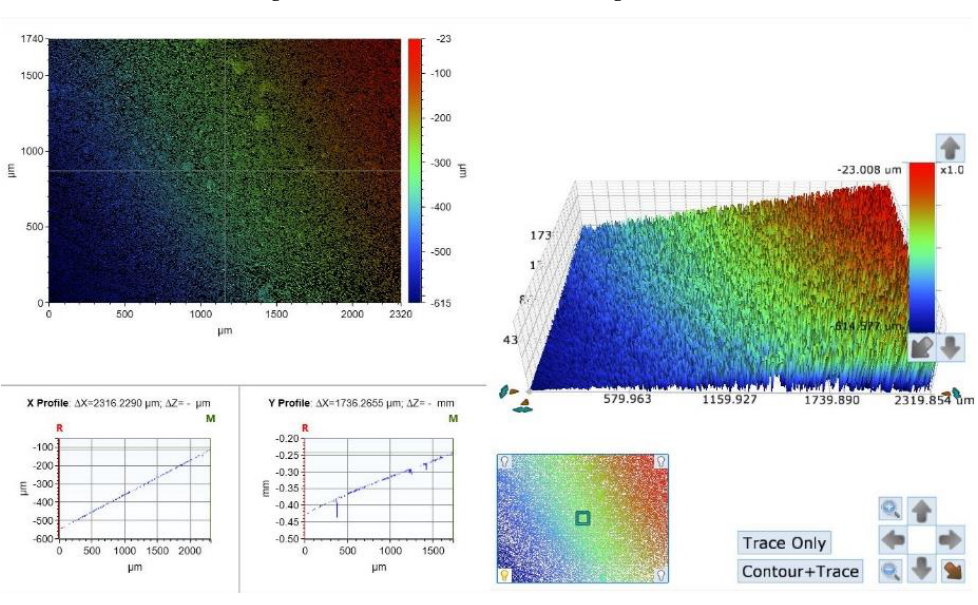
Figure 3. A surface scan photograph and a topography graph of a polishing discs group sample. An evenly polished surface with a homogenous grain pattern.